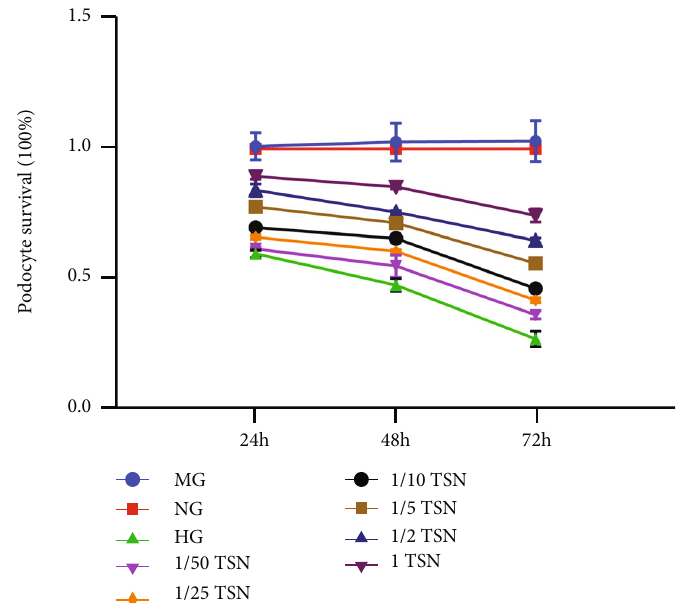
Figure 3: E ff ect of TSN on the viability of high glucose-induced podocytes. CCK-8 assay results showed that TSN increased the viability of the podocyte injury model induced by high glucose. The podocytes were cultured for 24h, 48 h, and 72 h with 30 mM high glucose and di ff erent concentrations of TSN ((1/50, 1/25, 1/10, 1/5, 1/2, and 1). Cell viability is expressed as mean ± SD ( n = 3